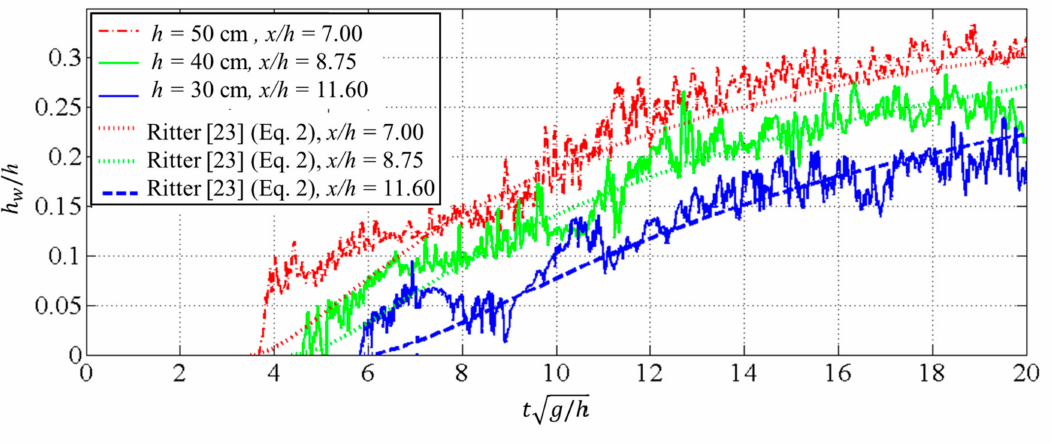
Figure 6. Non-dimensional dry bed condition water time-history surface profile: Comparison with Ritter’s (1892) solution. h w